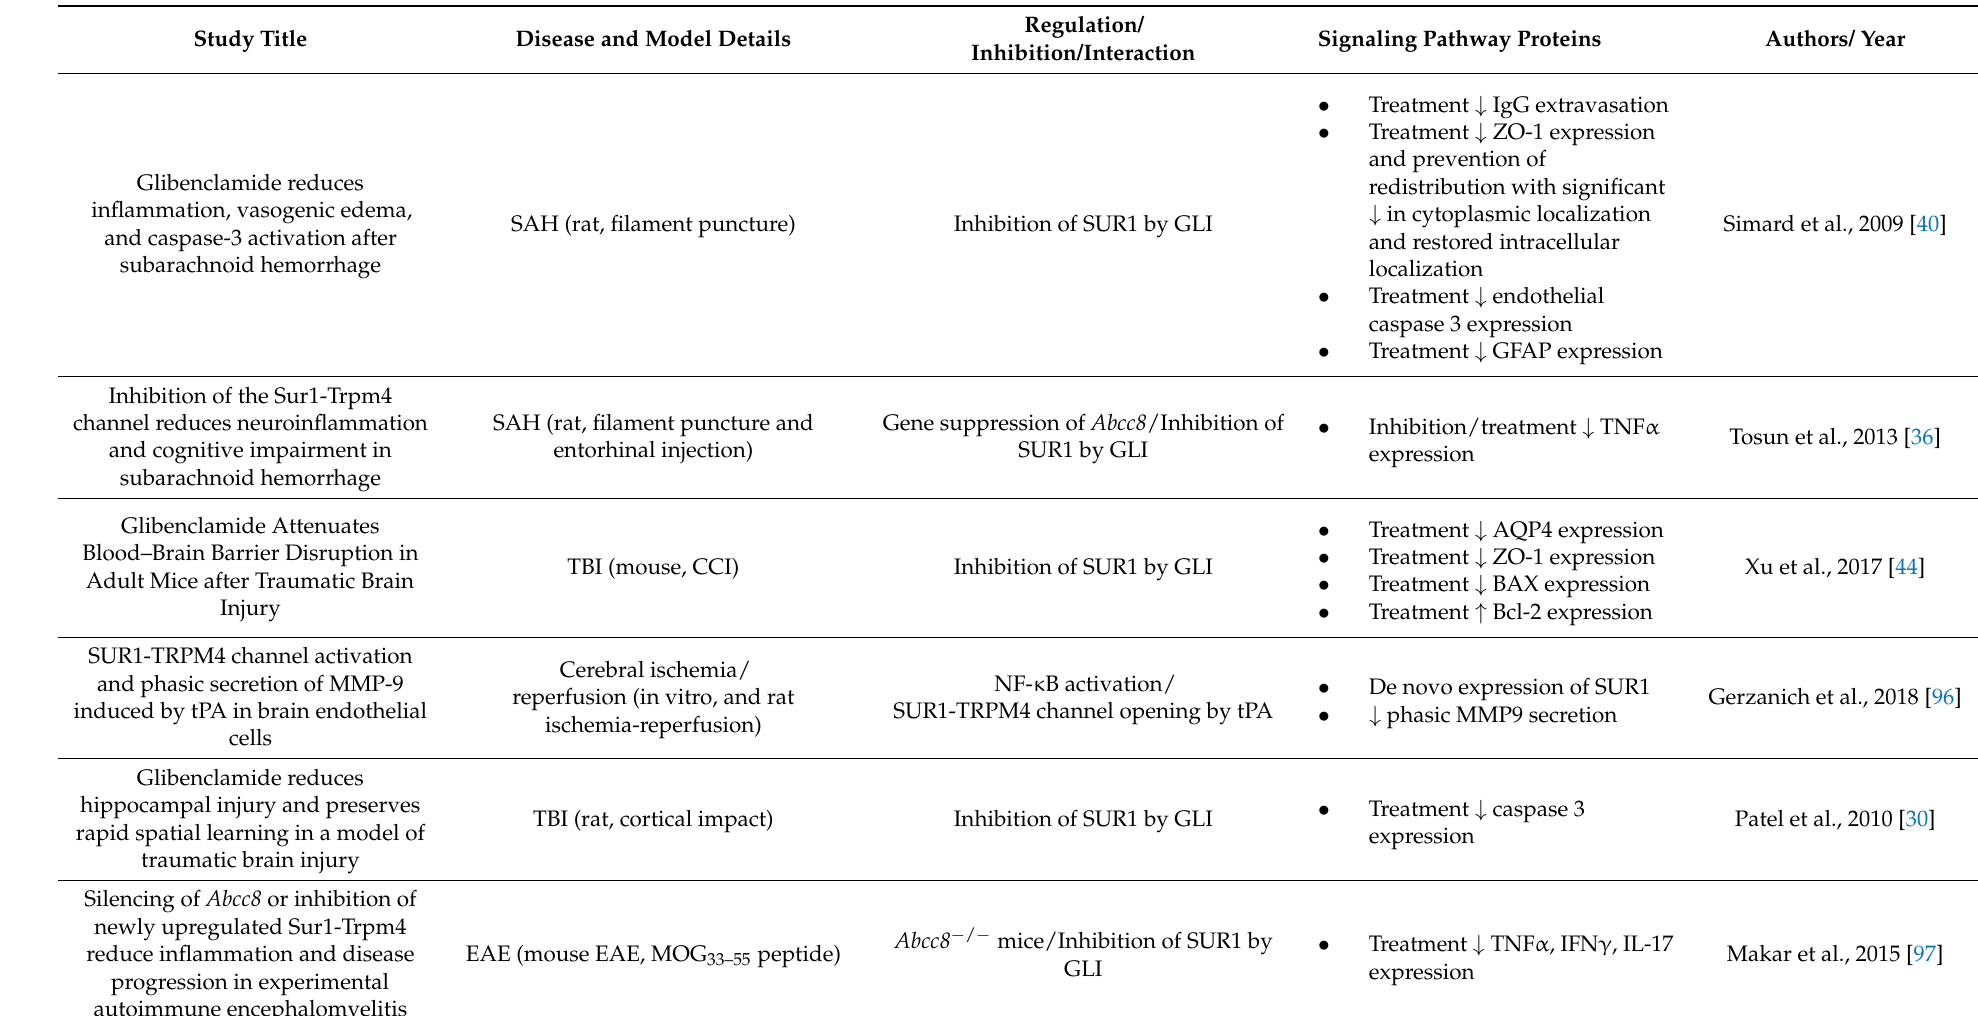
Table 1. Key SUR1 signaling